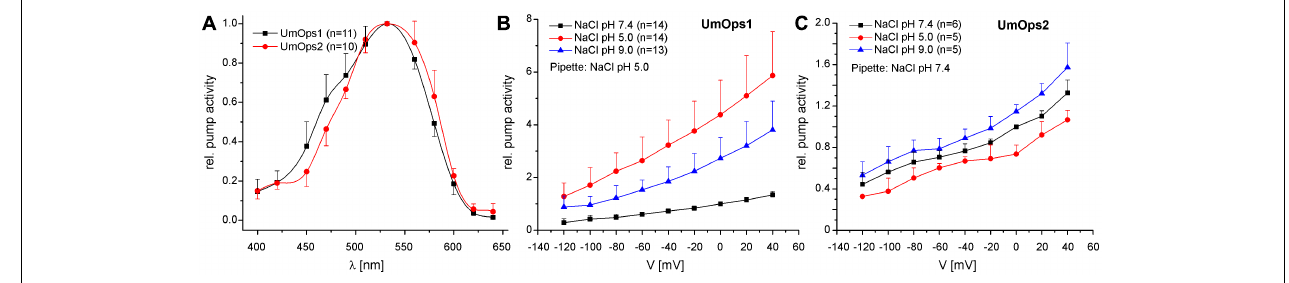
FIGURE 3 | Electrophysiological characterization of UmOps1 and UmOps2. (A) Action spectra of UmOps1 and UmOps2. The mean relative pump activity and standard deviation of n measurements as indicated are given in dependence of the wavelength used for excitation. Both rhodopsins show highest activation at 532 nm. In these measurements, NaCl pH 5.0 was used as pipette solution to support proton pumping at low light intensities. Current–voltage relation of UmOps1 (B) and UmOps2 (C) in a range of +40 to –120 mV after excitation with a 532 nm laser in different extracellular solutions as indicated. Shown is relative pump activity (mean + standard deviation of n measurements as indicated) normalized to the value obtained in bath solution NaCl pH 7.4 at 0 mV clamp voltage. Note that pump activity of UmOps1 is highest at extracellular pH 5.0, which is remarkable for an outward directed proton pump, as the gradient is working against the pump.